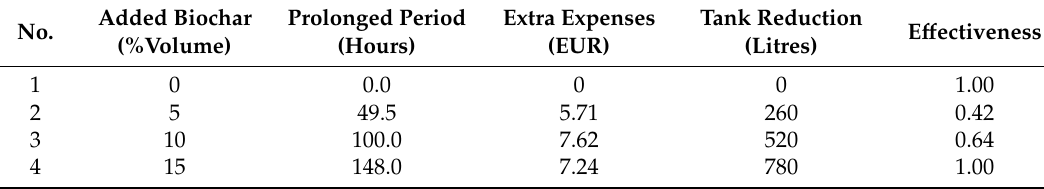
Table 5. Results for the sample thickness of 200 mm.